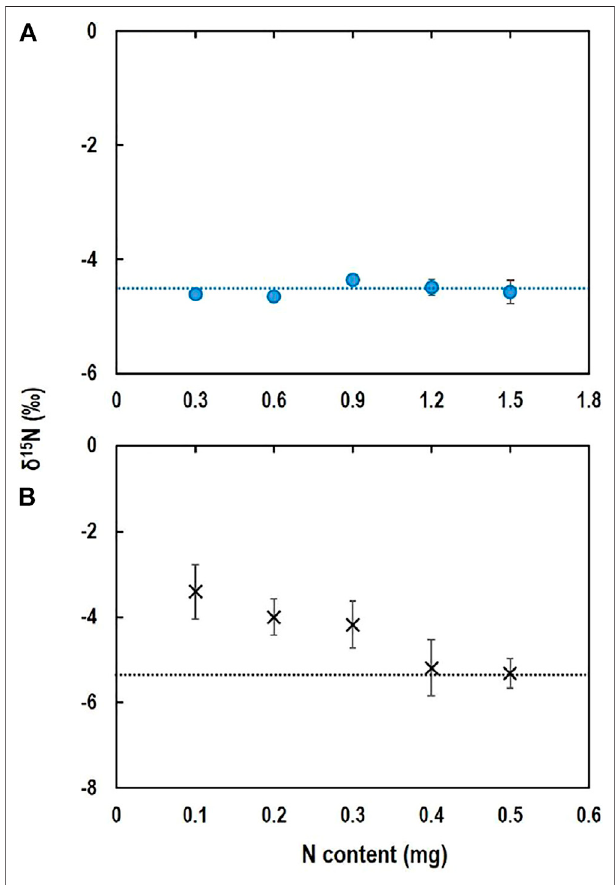
FIGURE 4 | δ 15 N-TDN (A) and δ 15 N-DON (B) measured with direct evaporation and determined using isotope mass balance equation, respectively. Horizontal broken-lines are the reference δ 15 N value of TDN (A) and theoretically calculated δ 15 N of DON (B) . Vertical bars are standard deviation of the means ( n = 4).